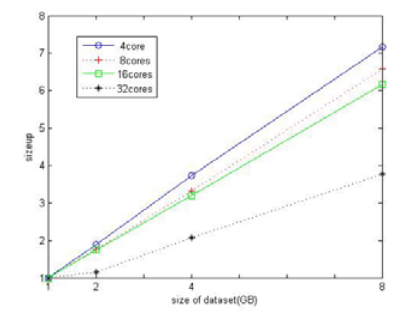
Figure6. Speedup performance